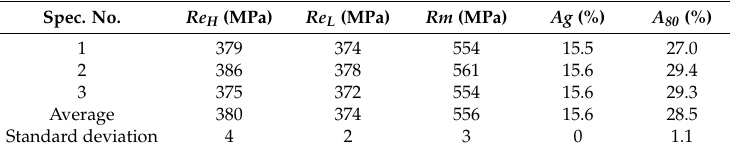
Table 2. The mechanical properties of steel S355J2 + N.